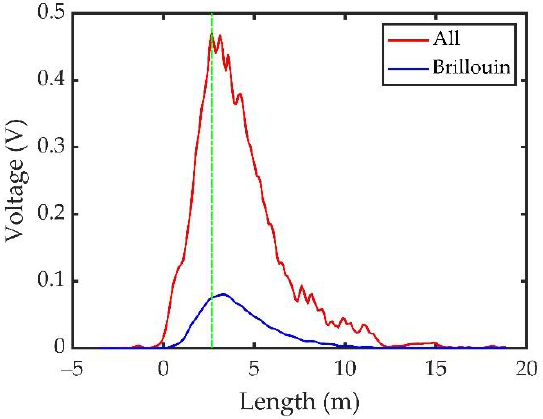
Figure 10. Results of the Brillouin energy measurement experiment before and after passing through the iodine cell after averaging 100 times.